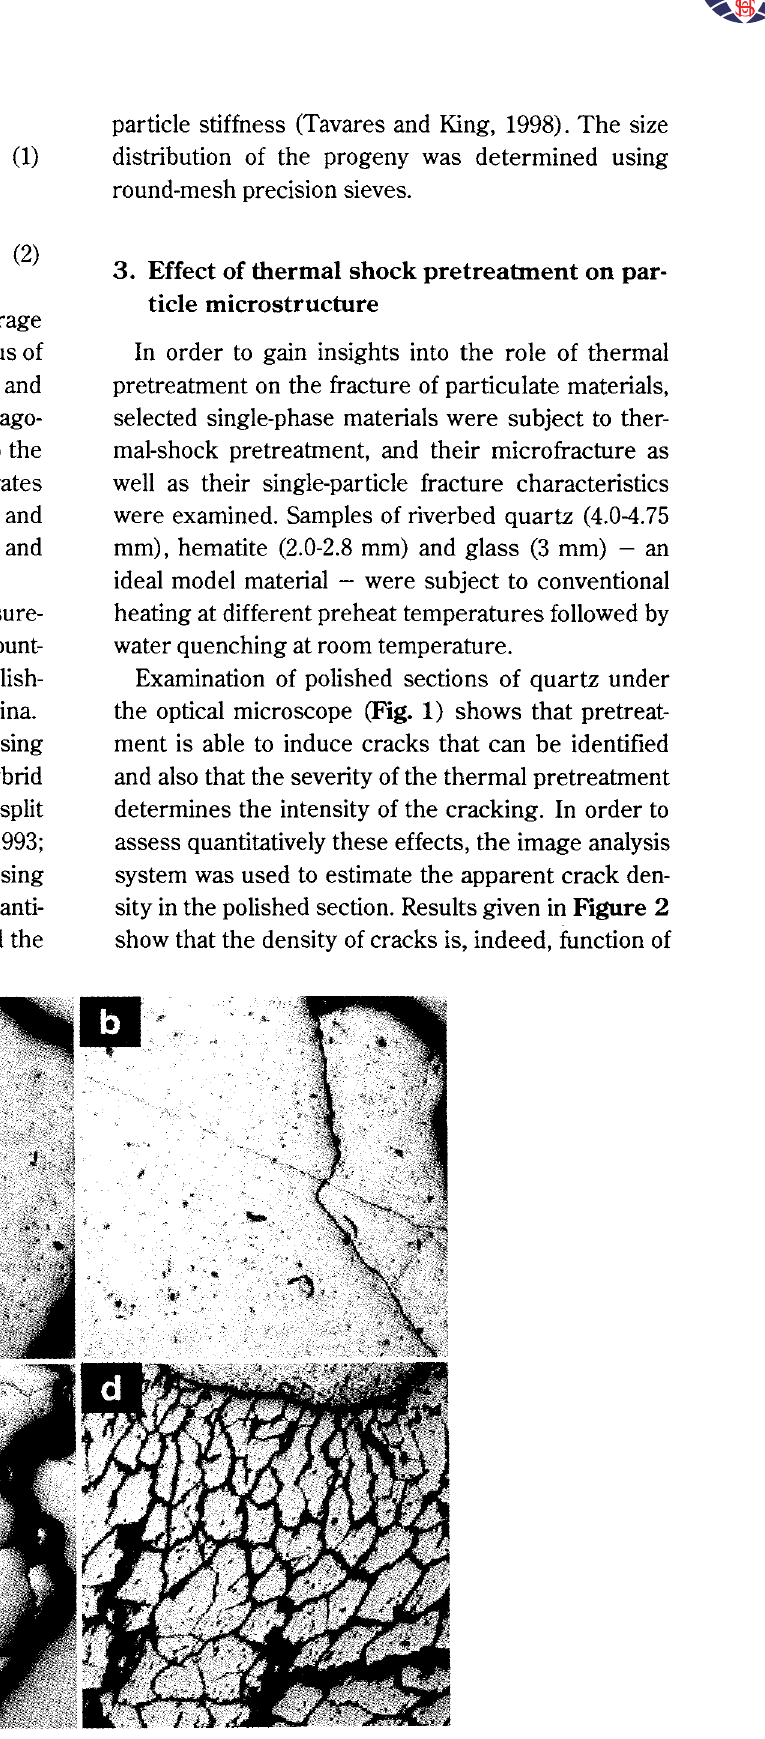
Fig. 1 Micrographs of untreated (a) and heated and water quenched quartz particles: (b) heated to 200°C, (c) heated to 600°C, and (d) heated to 1000°C. Horizontal distance in each micrograph is 1.2